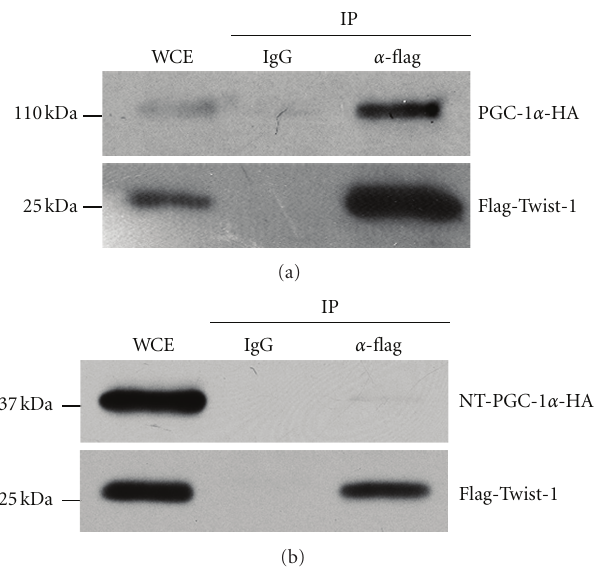
Figure 2: Interactions of Twist-1 with PGC-1 α but not with NT-PGC-1 α . PGC-1 α -HA (a) and NT-PGC-1 α -HA (b) were co- expressed with Flag-Twist-1 in COS-1 cells. Immunoprecipitates with IgG or anti-Flag antibody were separated by SDS-PAGE and immunoblotted with anti- PGC-1 α (a, top panel) or HA antibody (b, top panel). Expression of Flag-Twist-1 was confirmed by probing with anti-Flag antibody (a and b, bottom panels).